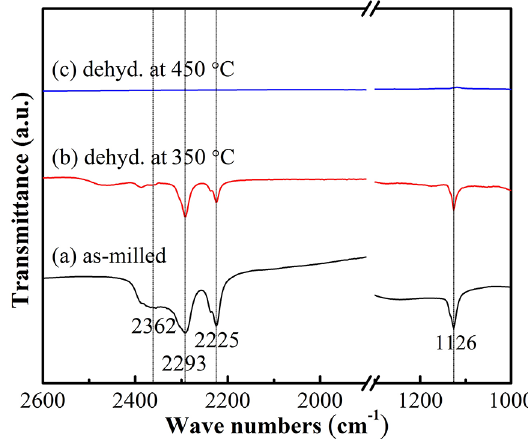
. Figure 5. FTIR spectra of the LiBH 4 (a) and dehydrogenated at 350 (b) and 450 °C (c),